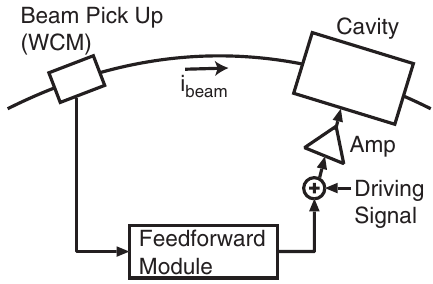
FIG. 2. A conceptual diagram of the rf feedforward method. The feedforward module generates (cid:1) i voltages are canceled.